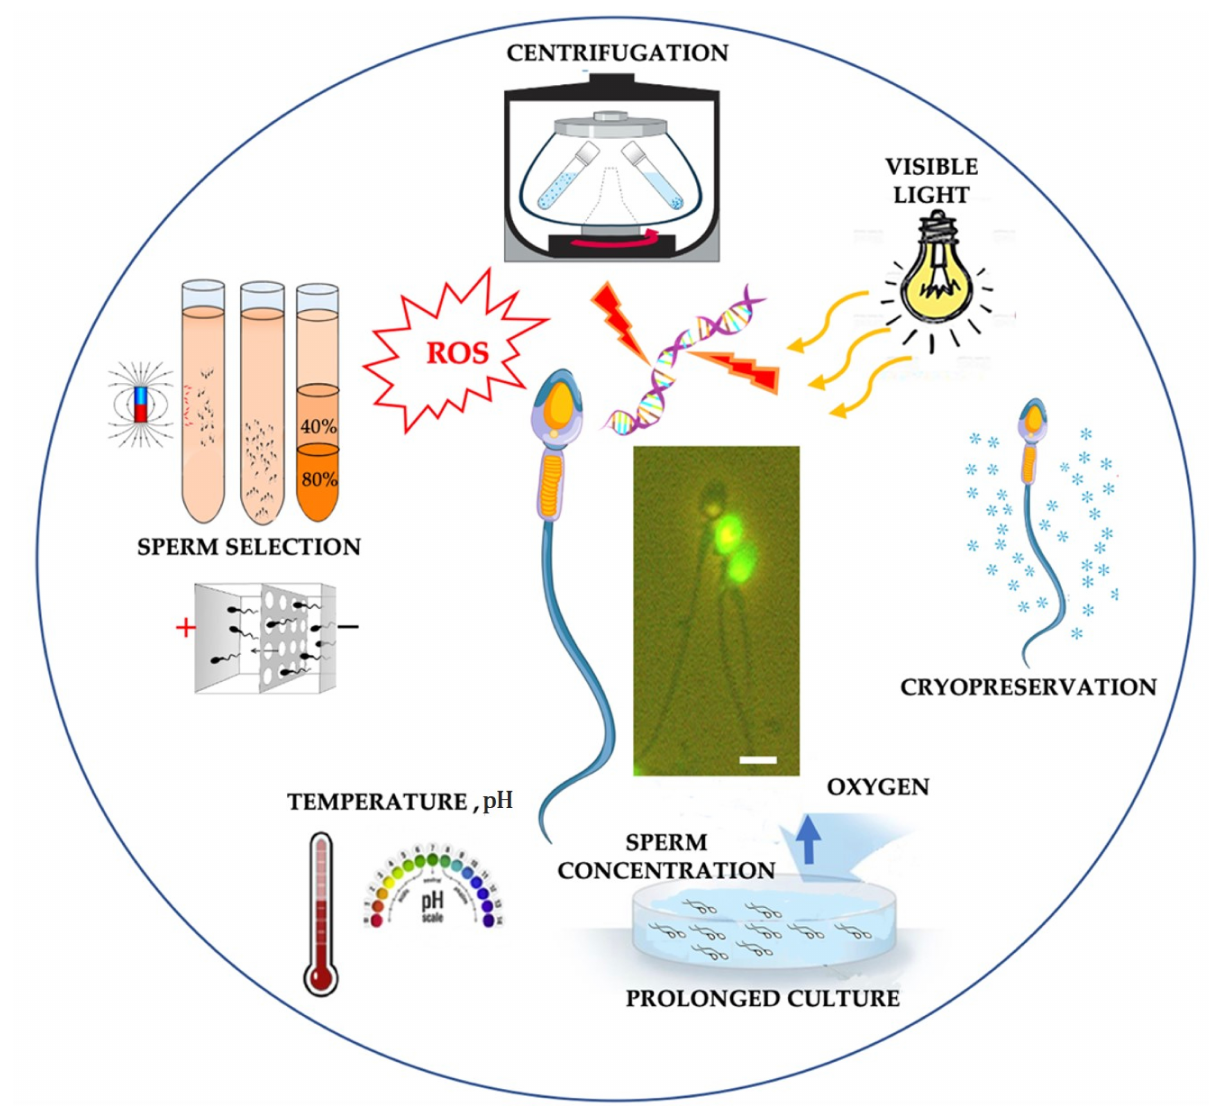
Figure 1. Factors inducing oxidative stress during sperm manipulation in ART. Central micrographs: TUNEL-labeled human sperm. Bar, 5 µ m. Sperm drawing is modified from https://www.vecteezy.com/vector-art/1434164-human-sperm- or-spermatozoa-cell-structure (accessed date 3 March